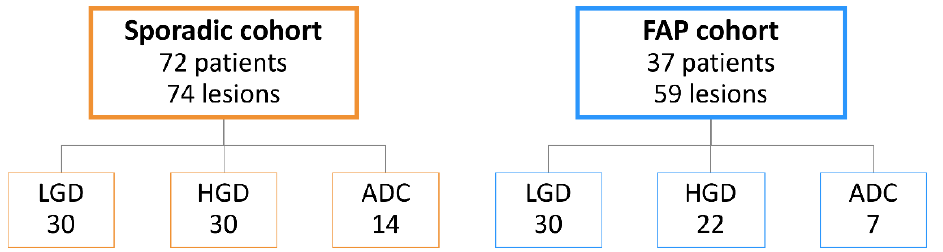
Figure 1. Cohort characterization, encompassing sporadic and Familial Adenomatous Polyposis (FAP) lesions. LGD, low-grade dysplasia; HGD, high-grade dysplasia; ADC, invasive